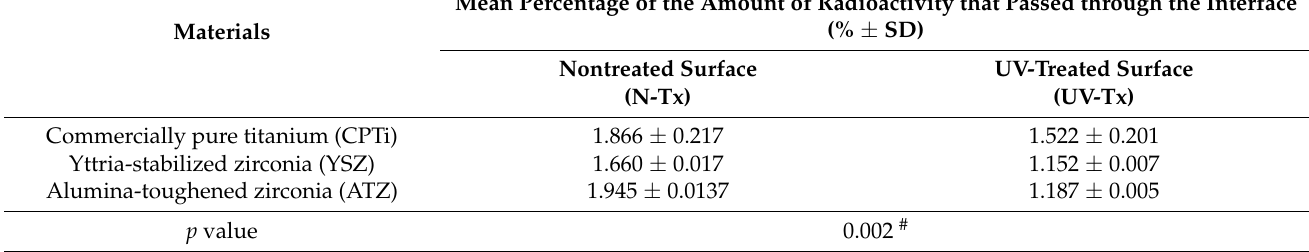
Table 2. Mean percentage of tritiated water (HTO) penetrating through the soft tissue–material interface. Materials Materials